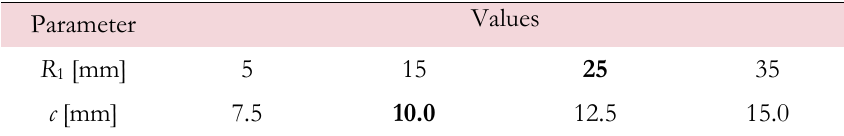
Table 1: The numerical values assigned to the parameters studied in the numerical analysis.